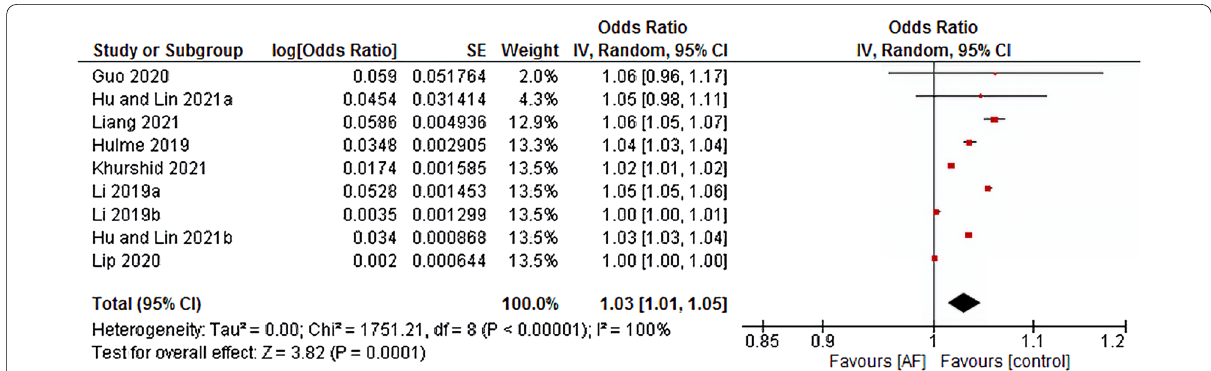
Fig. 2 Forest plot of the association between C 2 HEST score and atrial fibrillation. CI confidence interval